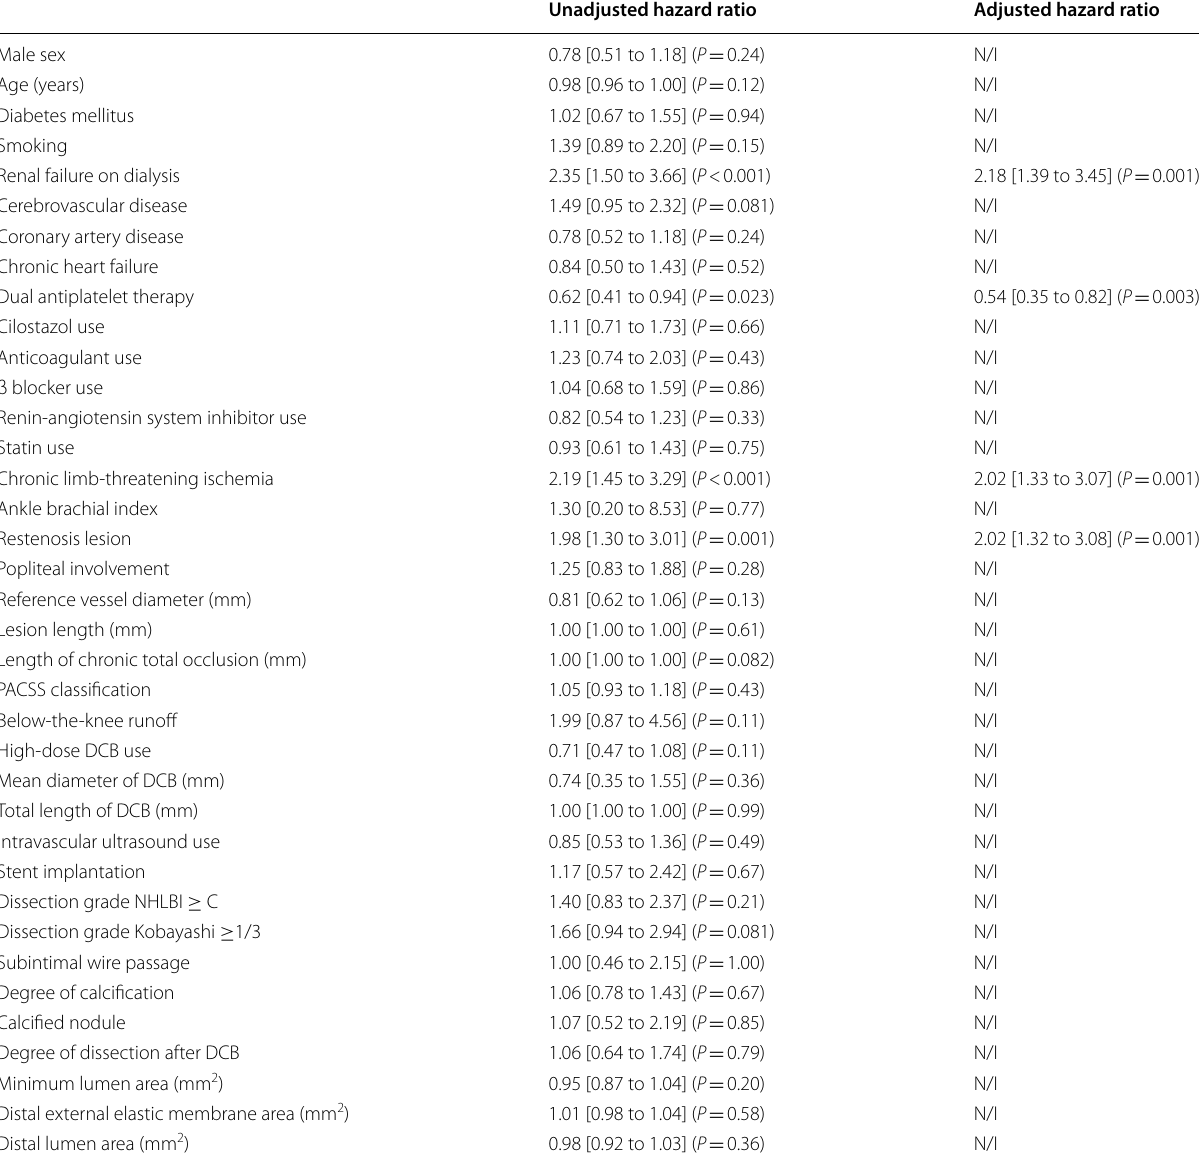
Table 2 Association of baseline characteristics with 1-year restenosis